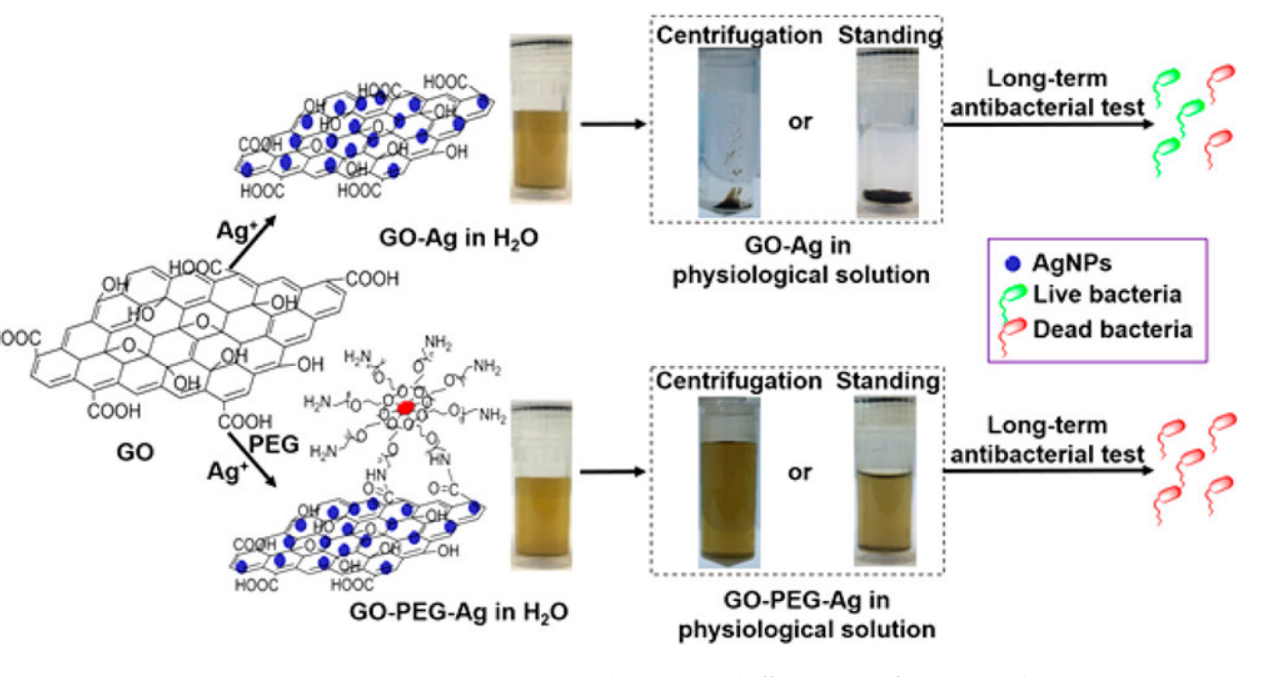
Figure 8. Long-term stability and antibacterial effectiveness of a PEGylated GO–Ag nanocomposite. (Adapted with permission from Ref. [309]. 2017, Zhao et al. More details on “Copyright and Licensing” are available via the following link: https://www.mdpi.com/ethics#10 (accessed on 10 October